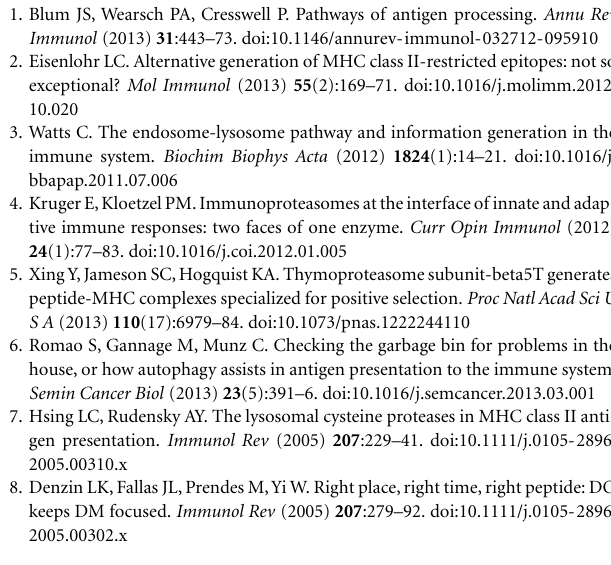
FIGURE 1 | Multiplex analysis of antigen-specific T cells with mass cytometry based combinatorial tetramer staining . 1. Starting with a single blood or tissue sample, lymphocytes can be simultaneously stained with over 100 different combinatorially encoded heavy-metal labeled peptide-MHC tetramers. 2.To do this, tetramers are mixed into a single cocktail prior to cell staining. 3.The same cells are also stained with a cocktail of heavy-metal labeled antibodies for the purposes of probing the phenotypic and functional characteristics of the antigen-specific cells identified. 4. Prior to mass cytometry analysis, the